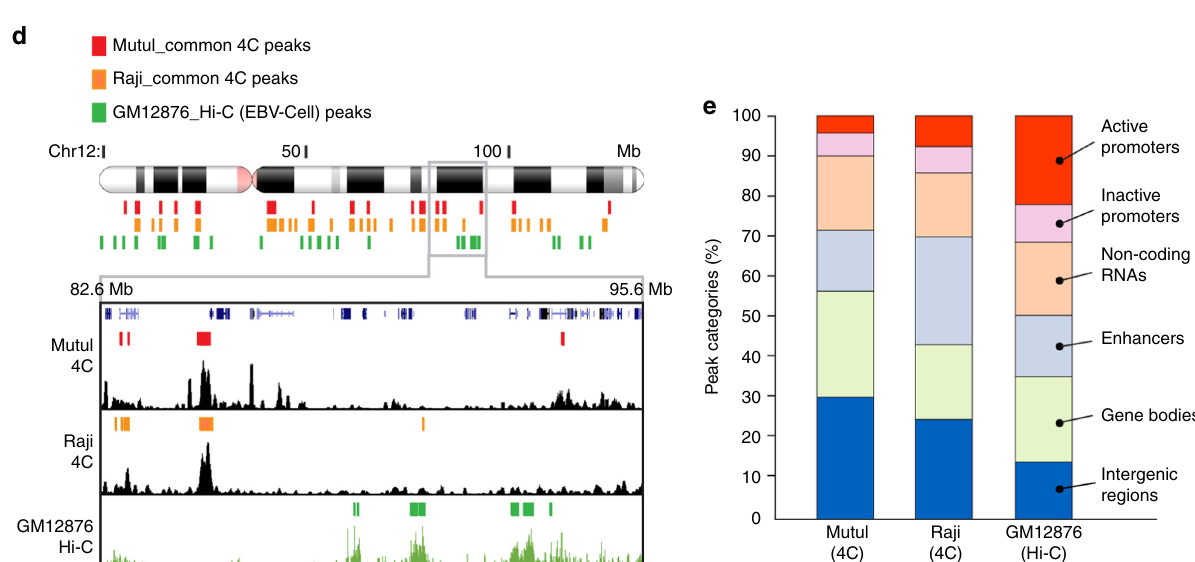
EBV 4C-associating genes. Since the highest frequency EBV tethering site overlapped with EBNA1 binding sites, we fi rst assayed the transcriptional expression of 4C target genes in Raji cells after shRNA depletion of EBNA1 (Fig. 6). EBNA1 was partially depleted by lentivirus transduced shRNA in Raji cells as measured by Western blot (Fig. 6a) and by ChIP assay (Supple- mental Fig. 8a, b). As expected, EBNA1 depletion led to a global reduction in EBV genome copy number as measured by FISH (Supplementary Fig. 8c, d). EBNA1 depletion also led to a loss of EBNA1-host chromosome tethering as measured by 3C analysis